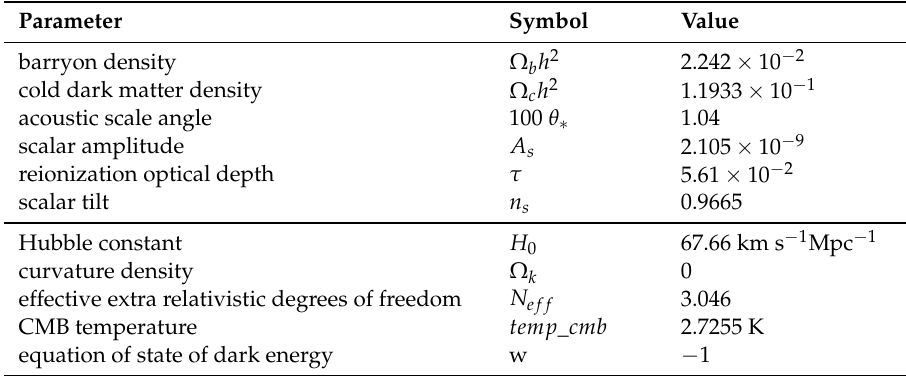
Table 1. Values used here for cosmological parameters in the Λ CDM model. We have used the Planck-18 68% interval from CMB power spectra, in combination with CMB lensing reconstruction and Baryonic Acoustic Oscillations